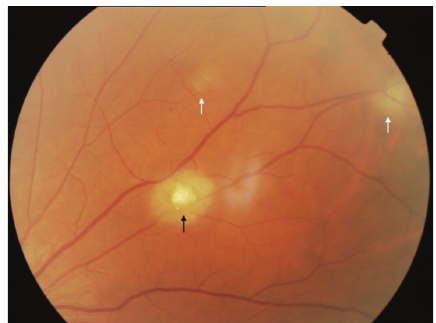
Figure 9: Astrocytic hamartoma of the retina in a patient with tuberous sclerosis complex. Multinodular or older tuberous body (black arrow). Translucent, blurry lesions or “younger tuberous bodies” in the periphery (white